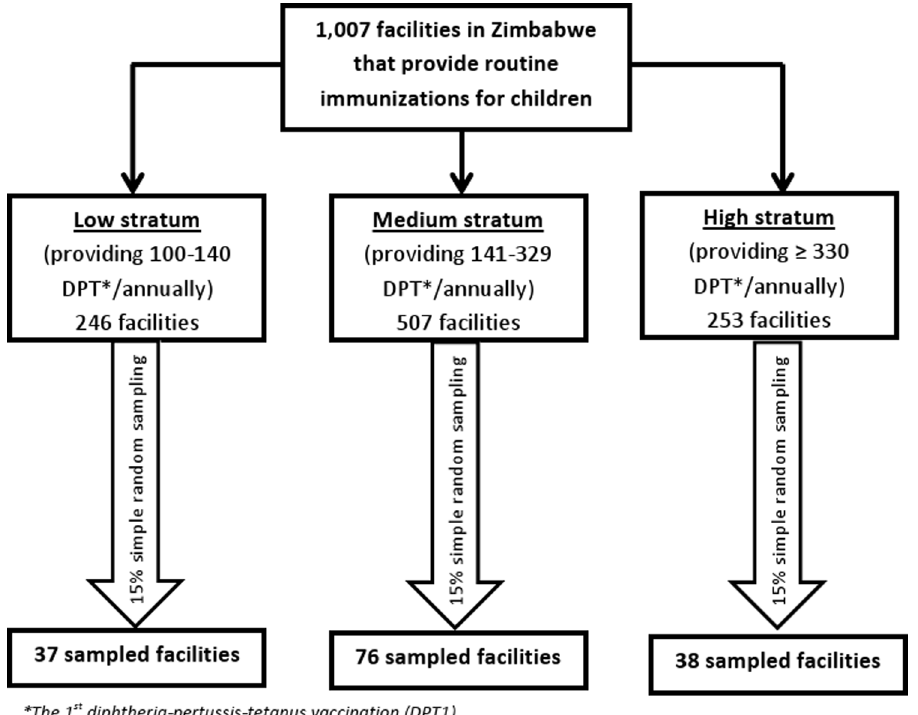
Figure 1. Sampling of Facilities and Response Rate by Stratum. DPT: The 1 st diphtheria-pertussis-tetanus vaccination.